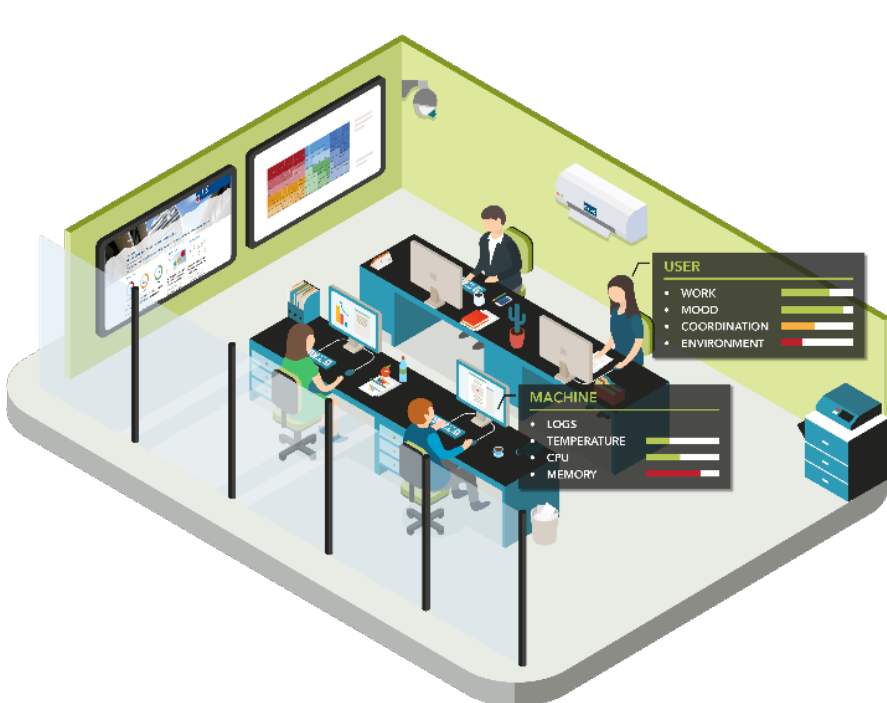
Figure 3. Operations Management Sensored-Workplace general